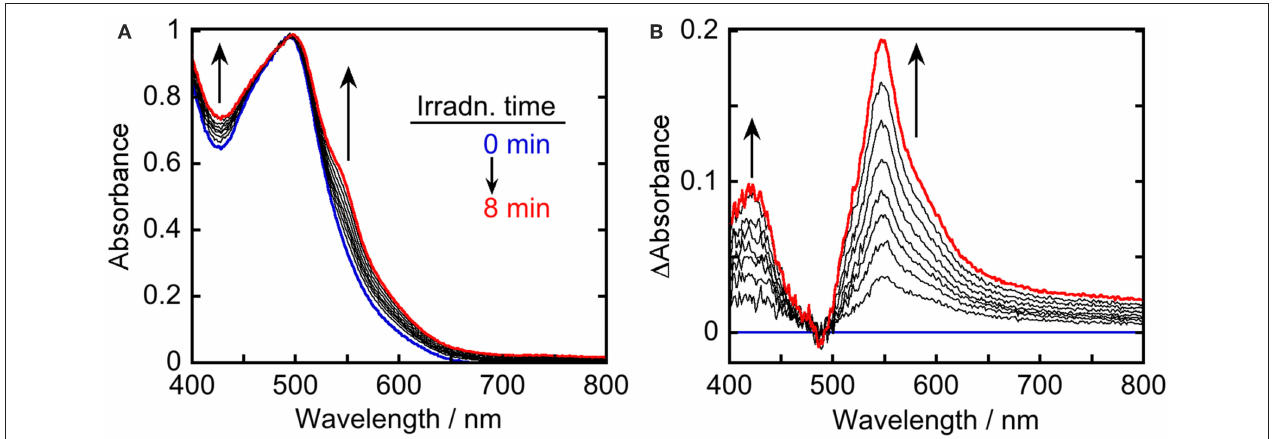
FIGURE 5 | UV-vis (A) absorption and (B) differential absorption spectral change of a DMA-TEOA (5:1 v/v, 4mL) solution containing Ru(pic) (0.1mM) and BIH (0.2M) during irradiation using light at λ ex = 480nm (0–8min at 1-min intervals). The incident light intensity was 5.0 × 10 − 9 einstein · s − 1 . Blue and red lines represent spectra at 0 and 8-min irradiation, respectively.